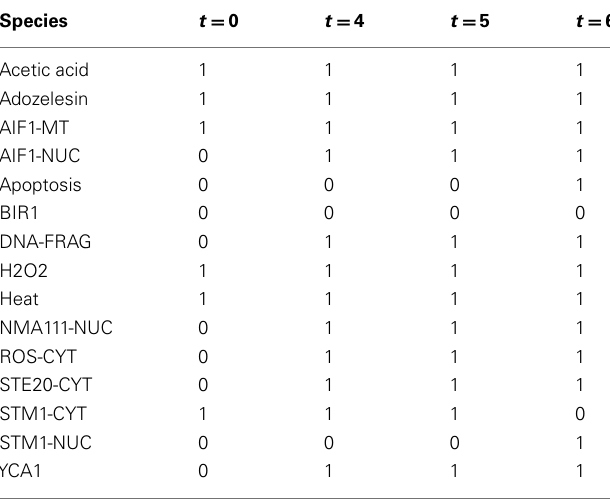
Table includes time scale scenario upon induction of all stimuli.T stands for differ- ent time steps.As an example ifAceticAcid is inducted to the cell at time point 0 it is expected to cause DNA Fragmentation at next time step and eventually ends to apoptosis in last